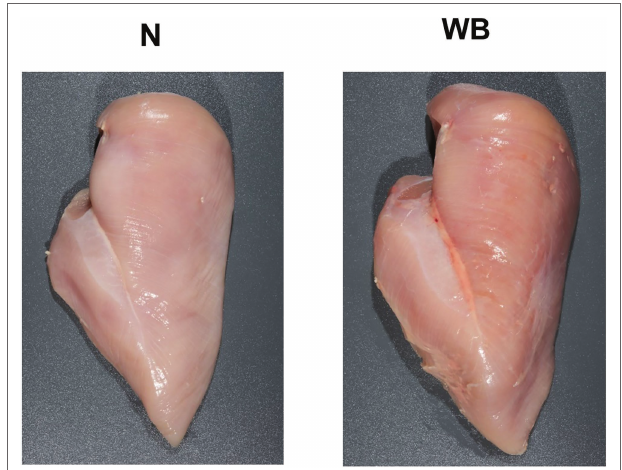
FIGURE 1 | Representative images of Woody Breast (WB) and normal (N) Pectoralis Major muscle utilized in this